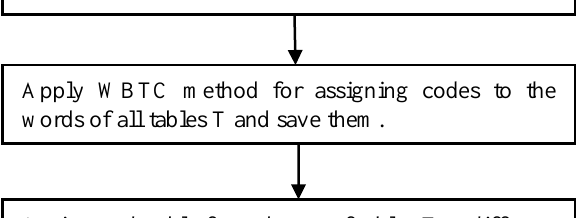
Figure 2. Pre-processing before Matching of